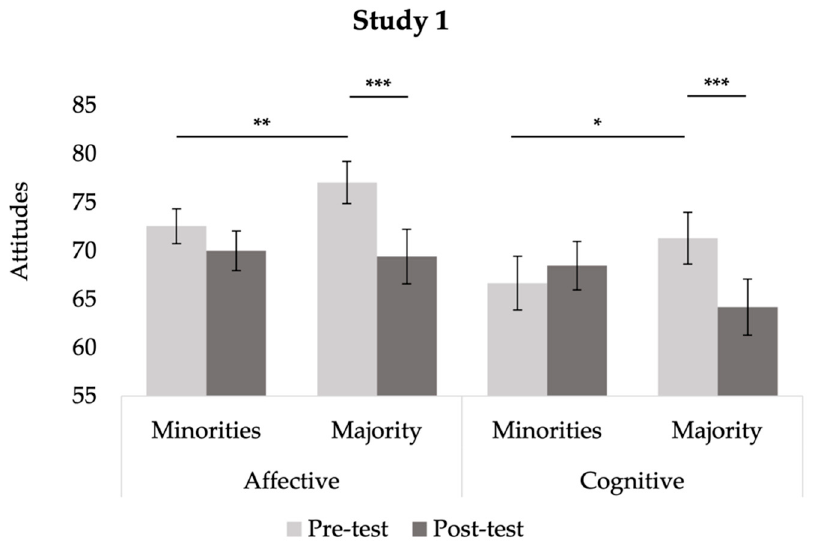
Figure 2. Plot depicting participants’ attitudes towards minorities and majorities at pre-test and post-test within each condition in Study 1. * p < 0.05, ** p < 0.01, *** p <